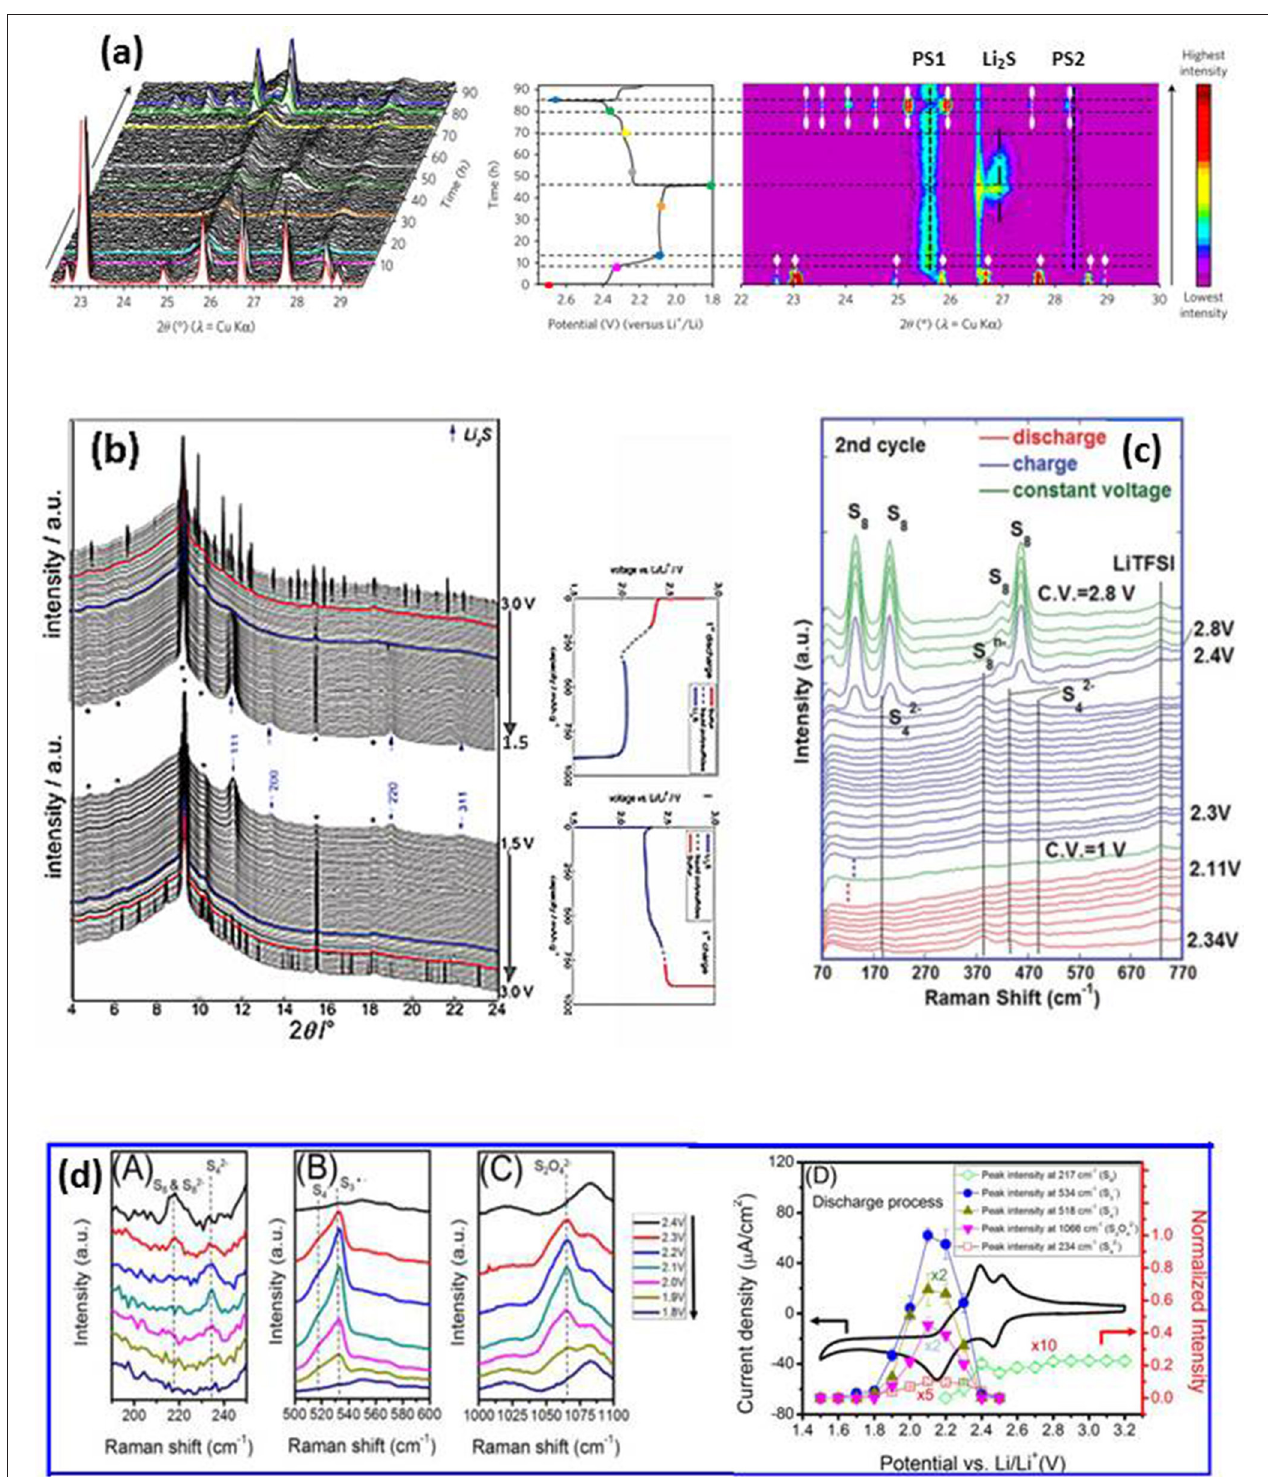
FIGURE 5 | (a) Development of XRD patterns of a Li-S cell with fused silica additive during first cycle (left), corresponding galvanostatic curve at C/50 (center) and XRD image plot (right). The colored patterns (left) correspond to colored dots on the cycling curve (center). α -S 8 and β -S 8 are represented by white lines with diamond and oval symbols, respectively (right). PS1 and PS2 are attributed to the PSs–SiO 2 interactions (vertical black dashed lines). Li 2 S is symbolized by a dashed-dotted black vertical line; * is from cell package (Conder et al., 2017); with permission from Springer Nature; (b) XRD patterns of a cell during 1st cycle with